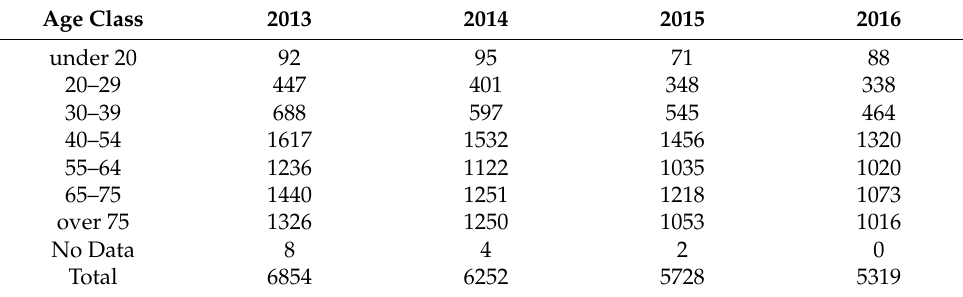
Figure 4. CVD admissions classified by age class. Table 5. Admissions for CVD classified by age